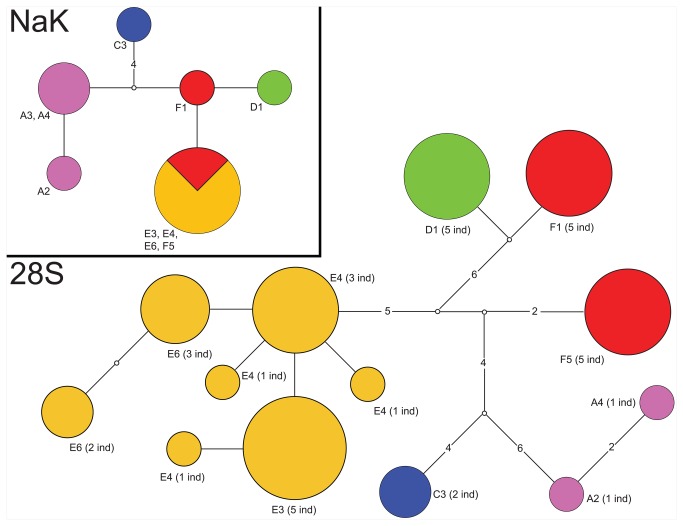
Haplotype networks for two nuclear gene fragments for Ligia from the Hawaiian Archipelago.The nuclear markers examined are the alpha subunit of the Sodium-Potassium ATPase (NaK) and the 28S rDNA gene. Colors correspond with those in Figure 1. Locality ID is indicated next to each allele (locality information is provided in Figure 1 and Table 1). Empty circles represent inferred unsampled (i.e., missing) alleles. Numbers within branches indicate number of mutational steps separating haplotypes. The size of circles is proportional to the frequency at which an allele was recovered. Numbers in parenthesis, indicate the number of individuals observed with the corresponding allele.